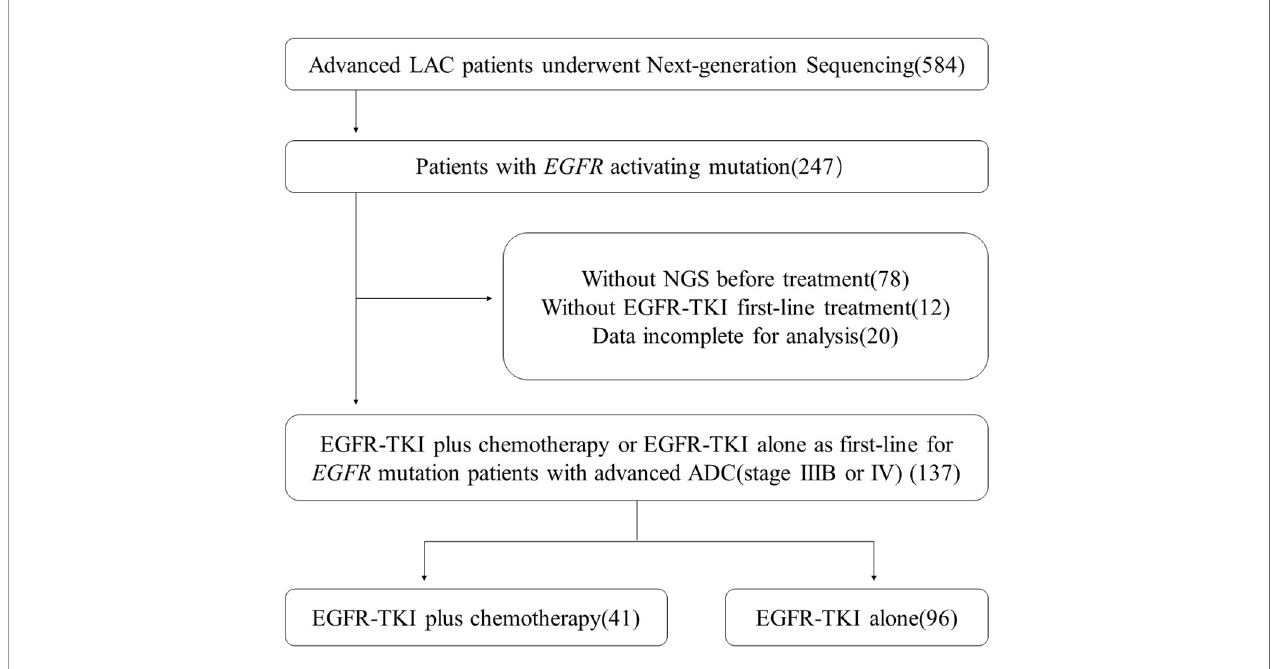
FIGURE 1 | Patient selection fl